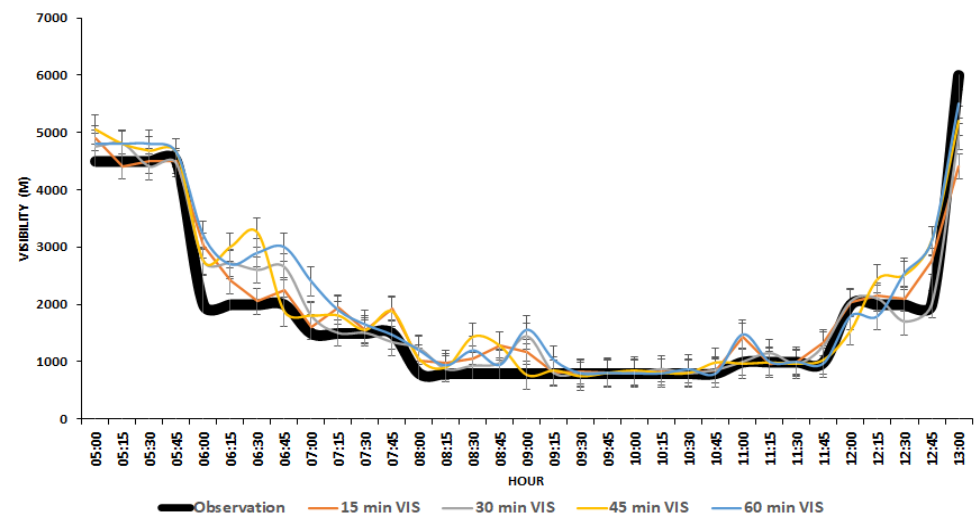
Figure 5. Regressive forecasts of visibilities and observations in the period from 5 a.m. to 1 p.m. on 23 June 2009.